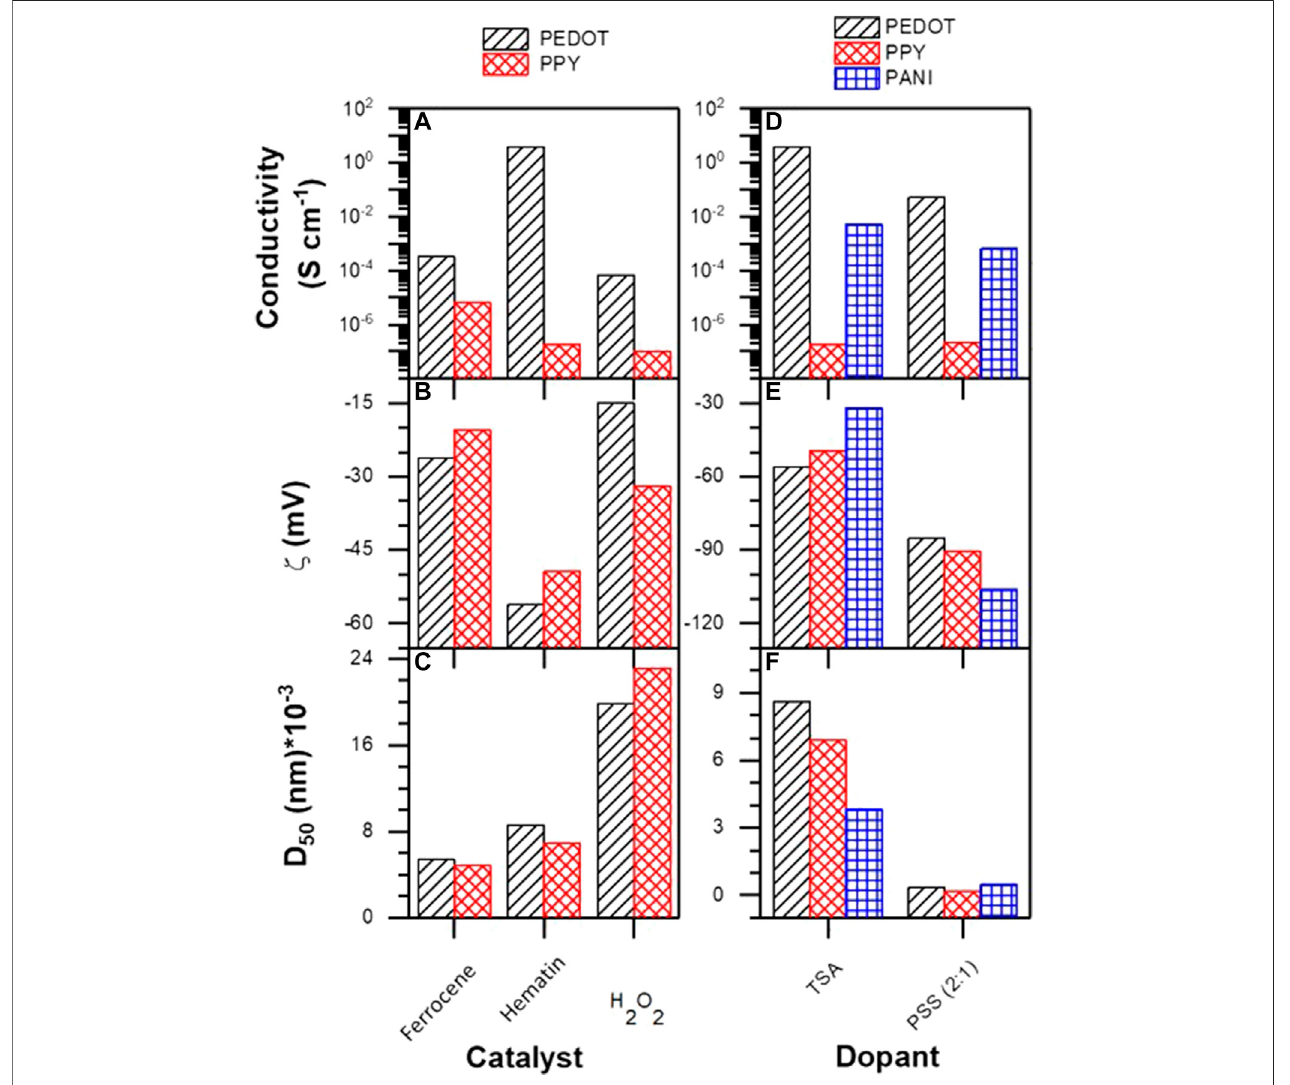
FIGURE 10 | (A) Conductivity, (B) Z-potential, (C) average particle size of PEDOT and PPY doped with TSA, (D) conductivity, (E) Z-potential, and (F) average particle size of PEDOT, PPY, and PANI doped with TSA and PSS.